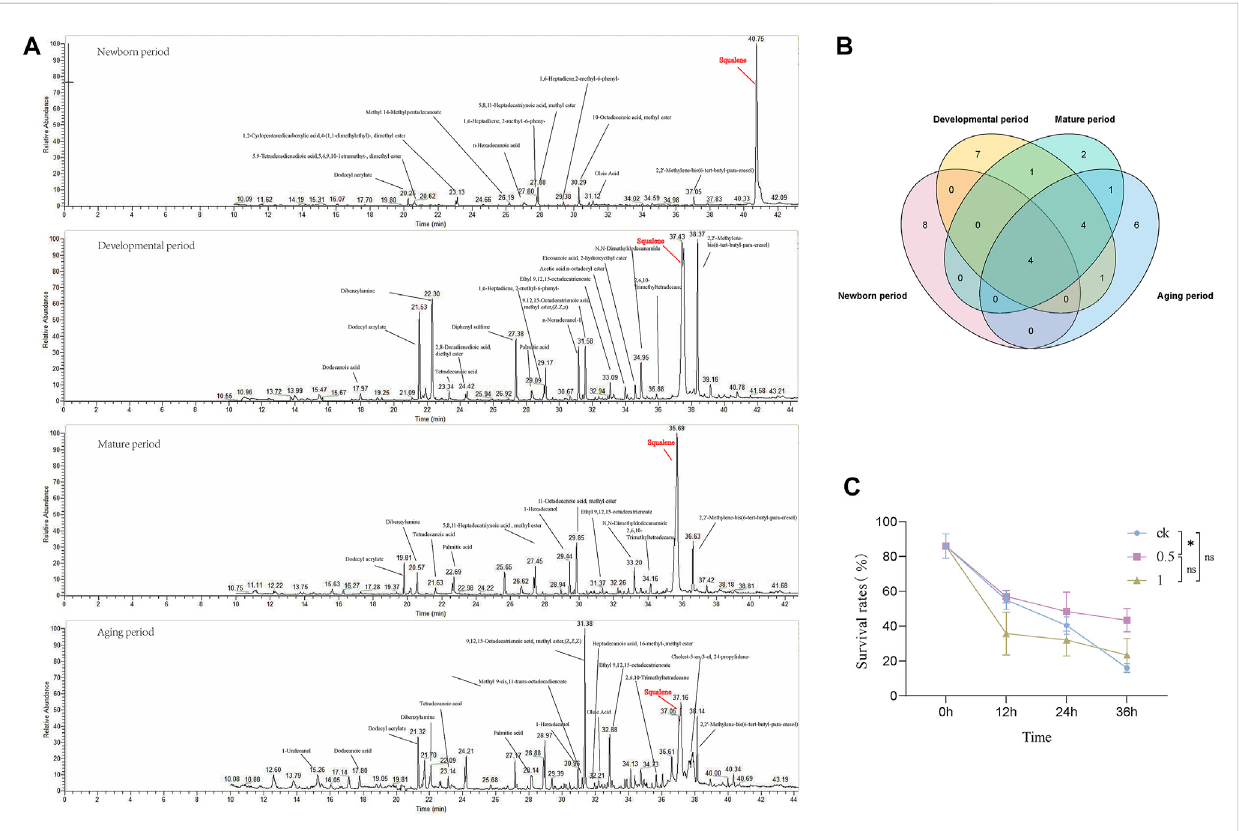
The developmental stages of MQD seminal vesicle by GC-MS analysis and in vitro validation experiments. (A) Newborn period, Developmental period,Matureperiod,andAgingperiod (B) Venndiagramofthedistributionofmetabolicsubstancesatvariousperiodsofseminalvesicledevelopmentin MQD. (C) Validating Squalene in vitro